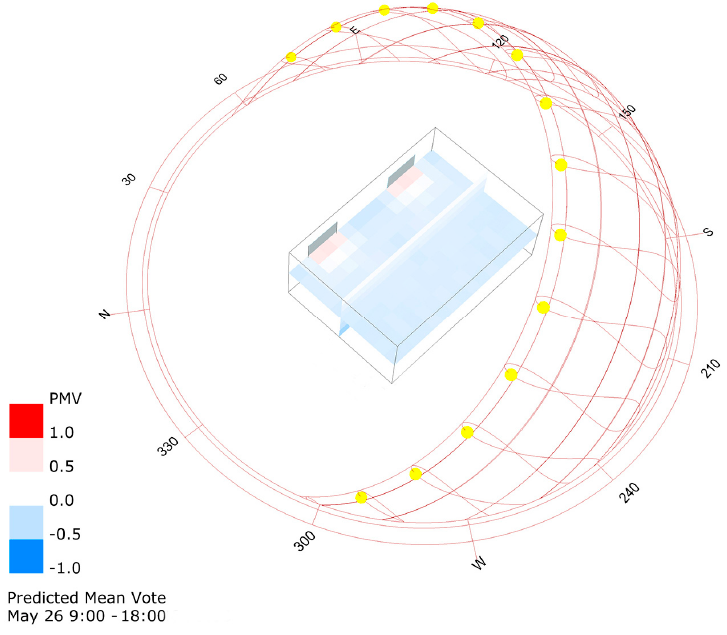
Figure 3. Predicted mean vote (PMV) preliminary analysis for a typical day of the test period: 26 May from 9:00 a.m. to 6:00 p.m.